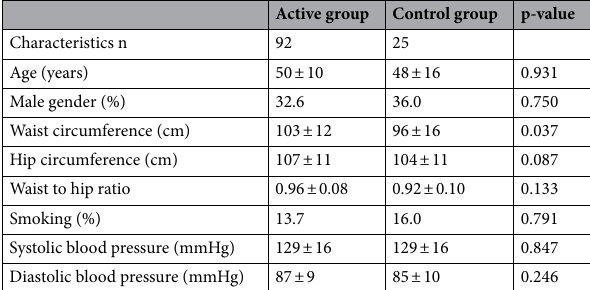
Table 1. Baseline characteristics of the study participants.